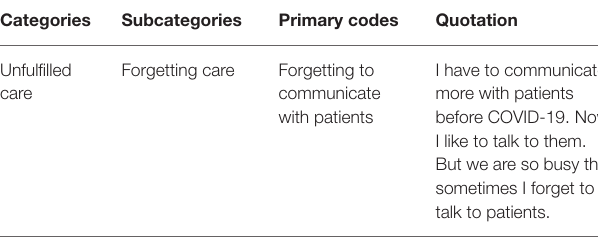
TABLE 3 | An example of data analysis.